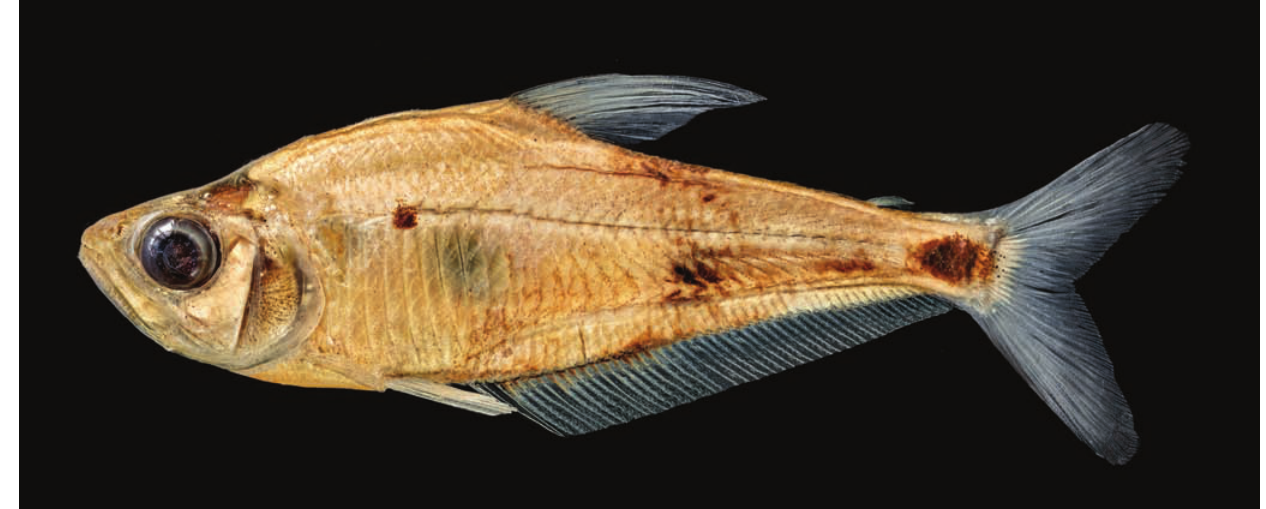
Fig. 24. Charax rupununi , MZUSP 27937, female, 38 mm SL, Brazil, Pará, lago Jacaré, rio